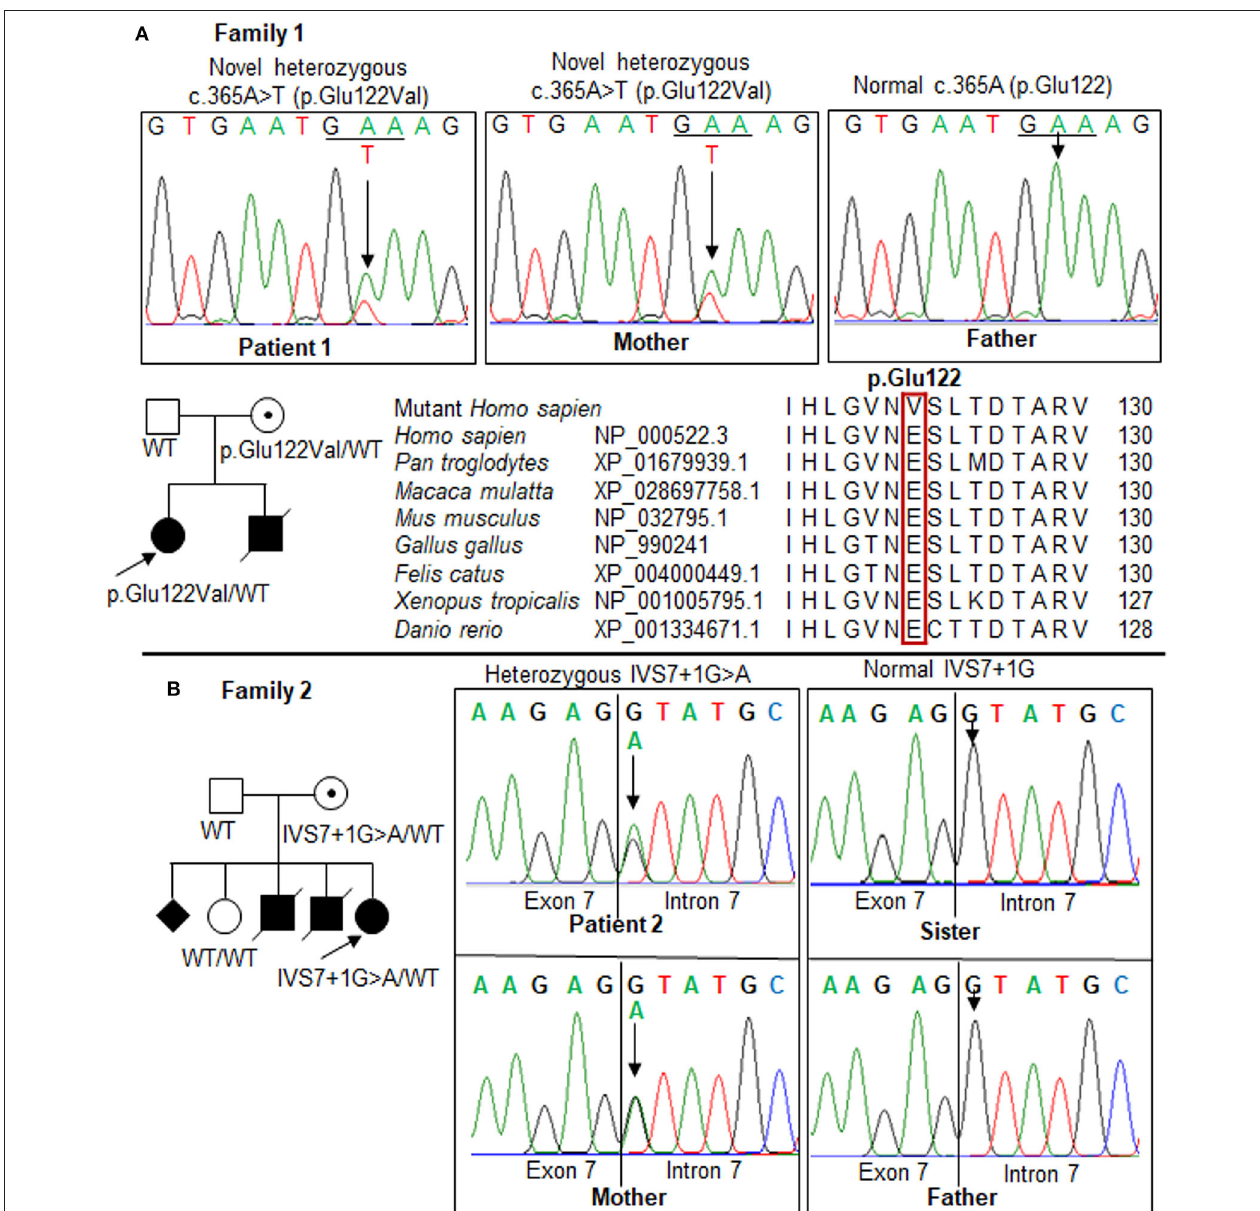
FIGURE 3 | Mutations in the OTC gene in the two families. Pedigrees of the two families show the affected ( solid ), unaffected ( open ), and asymptomatic carrier ( circle with dot ) members. Squares , males; circles , females; slashed symbol , deceased. The genotype is shown underneath each symbol ; WT, wild-type. (A) Patient 1 and her mother carried a novel heterozygous missense mutation, c.365A > T (p.Glu122Val), in exon 4. Multiple-sequence alignment of the amino acid sequences of OTC from different species revealed a complete conservation of the p.Glu122 residue across species ( red box ). (B) Identification of a mutation, IVS7 + 1G > A, in the OTC gene in the family of patient 2. The results showed a maternal carrier, while the father and sister were normal. The GenBank reference sequences of the human OTC gene are NM_000531.6 for the mRNA sequence and NC_000023.11 for the exon-intron